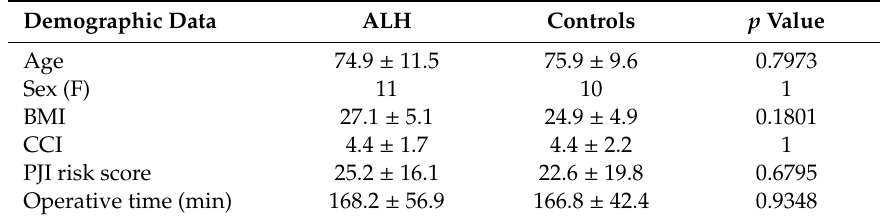
Table 1. Parameters used for the propensity score matching.